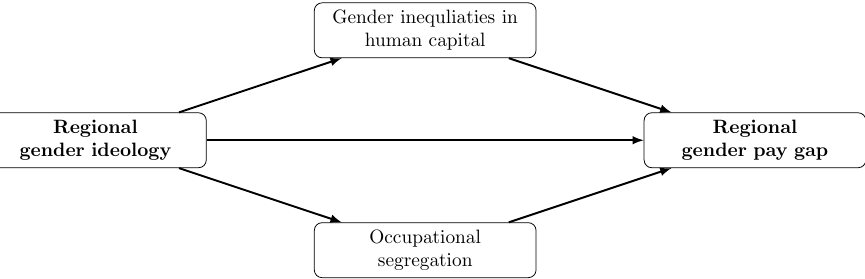
Figure 1. Schematic Depiction of How Gender Ideologies Affect Gender Pay